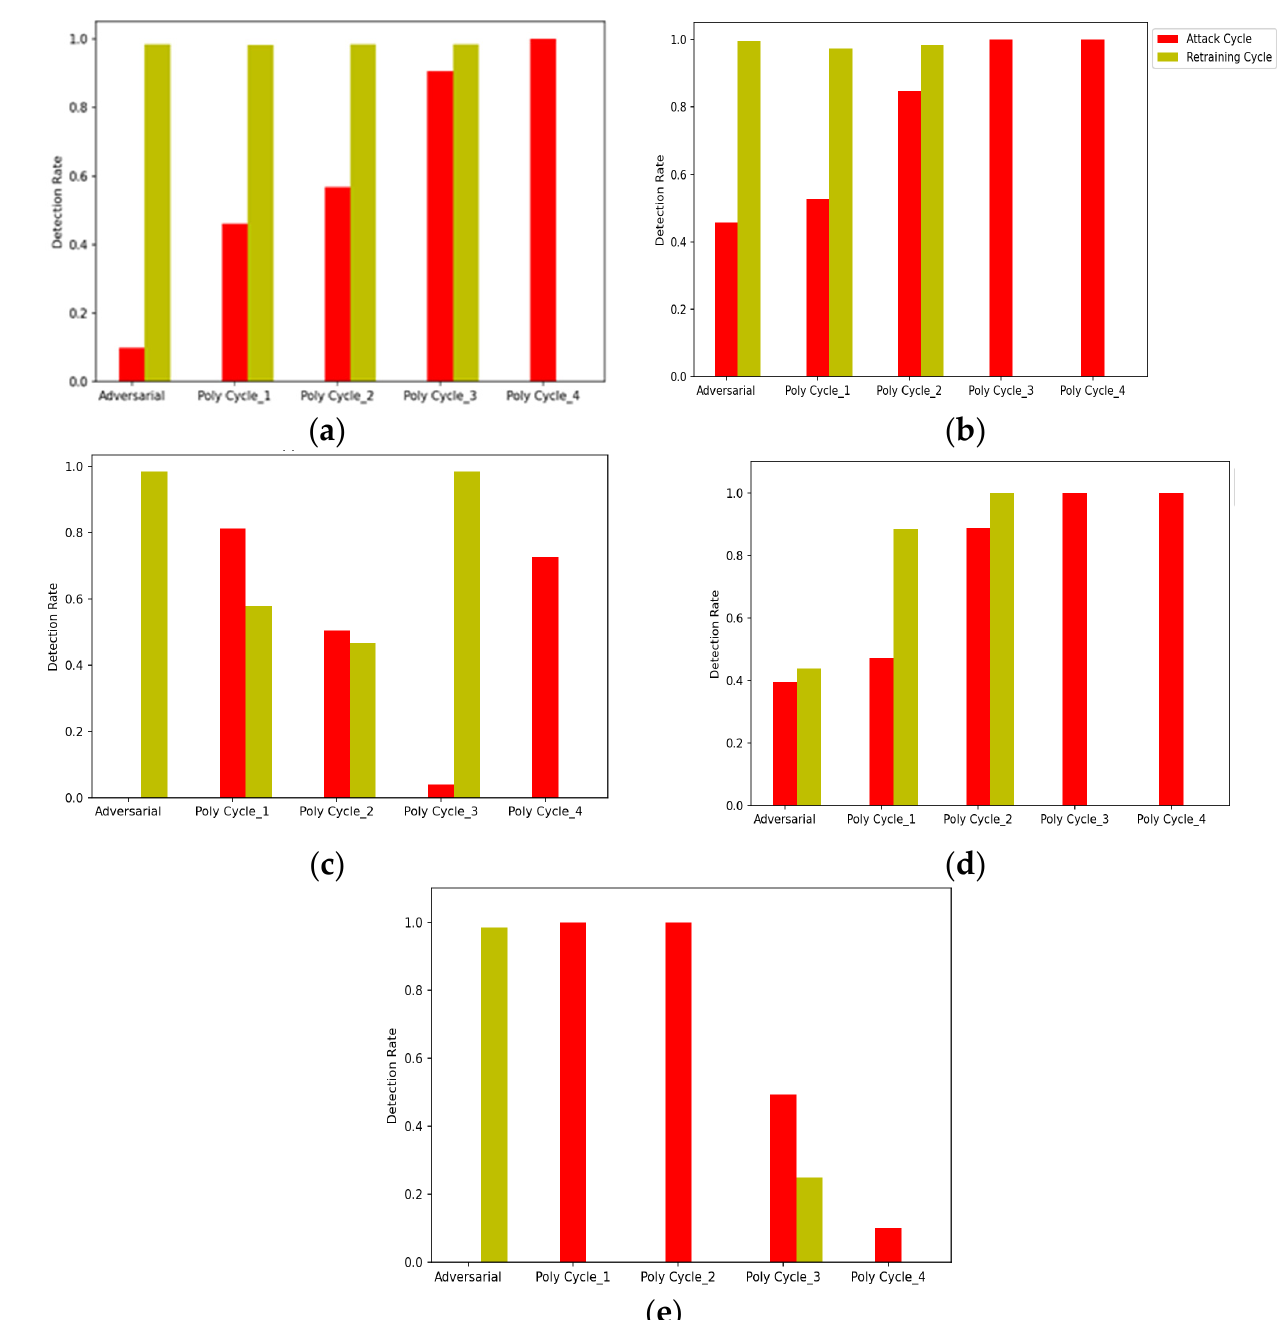
Figure 11. Comparative analysis of adversarial polymorphic attack detection rate for multiple IDS models. The adversarial polymorphic attacks are synthesized using Algorithm 3. ( a ) Random Forest (RF). ( b ) Decision Tree (DT). ( c ) Support Vector Machine. ( d ) K-Nearest Neighbor (KNN). ( e ) Naïve Bayes (NB).